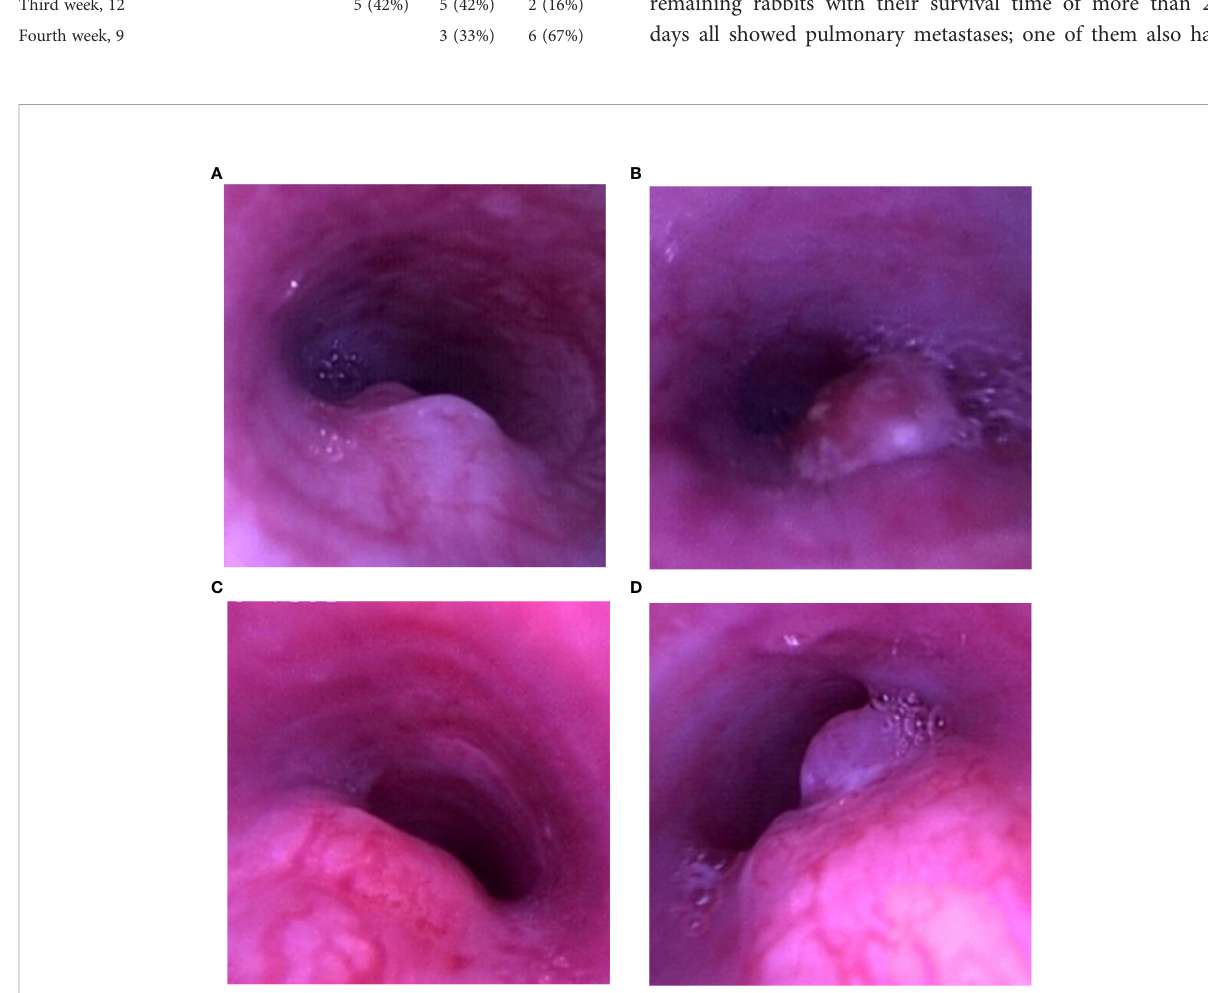
FIGURE 3 Airway stenosis types. (A) Tumor invasion of the airway wall. (B) Intraluminal tumor. (C) Extrinsic compression of the airway. (D) Combination